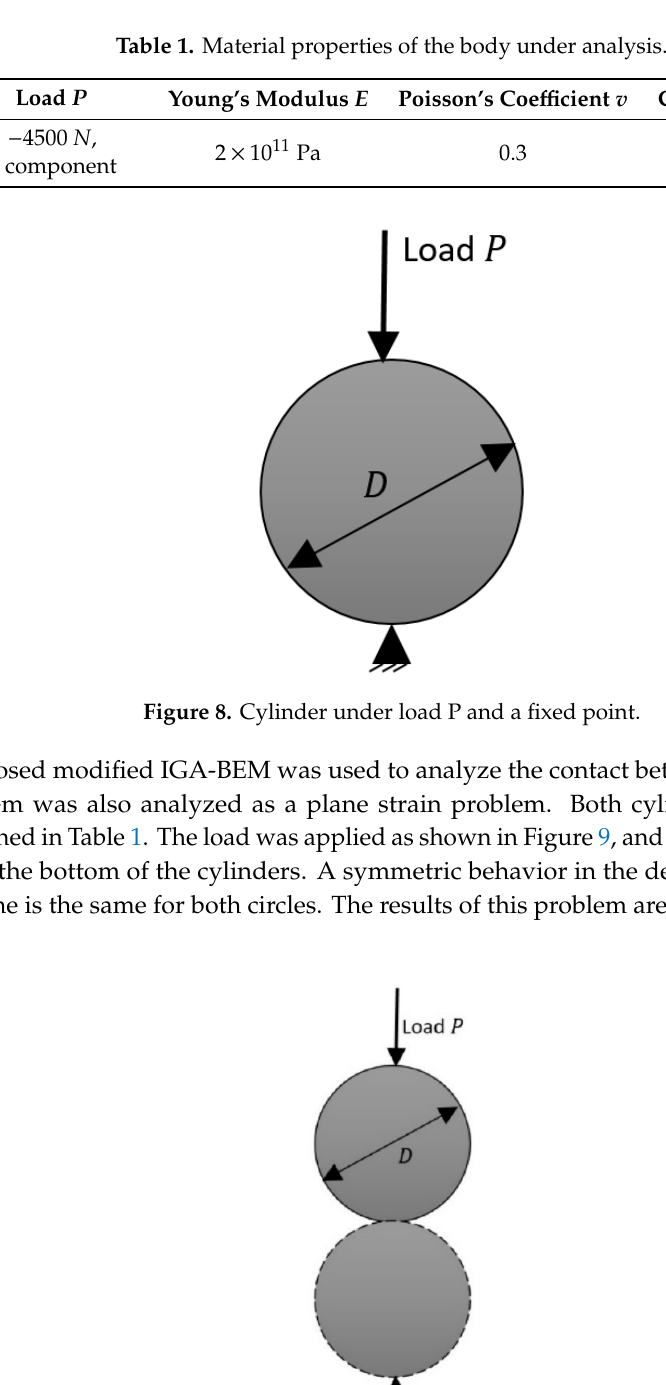
Figure 7. Flowchart of PSO.